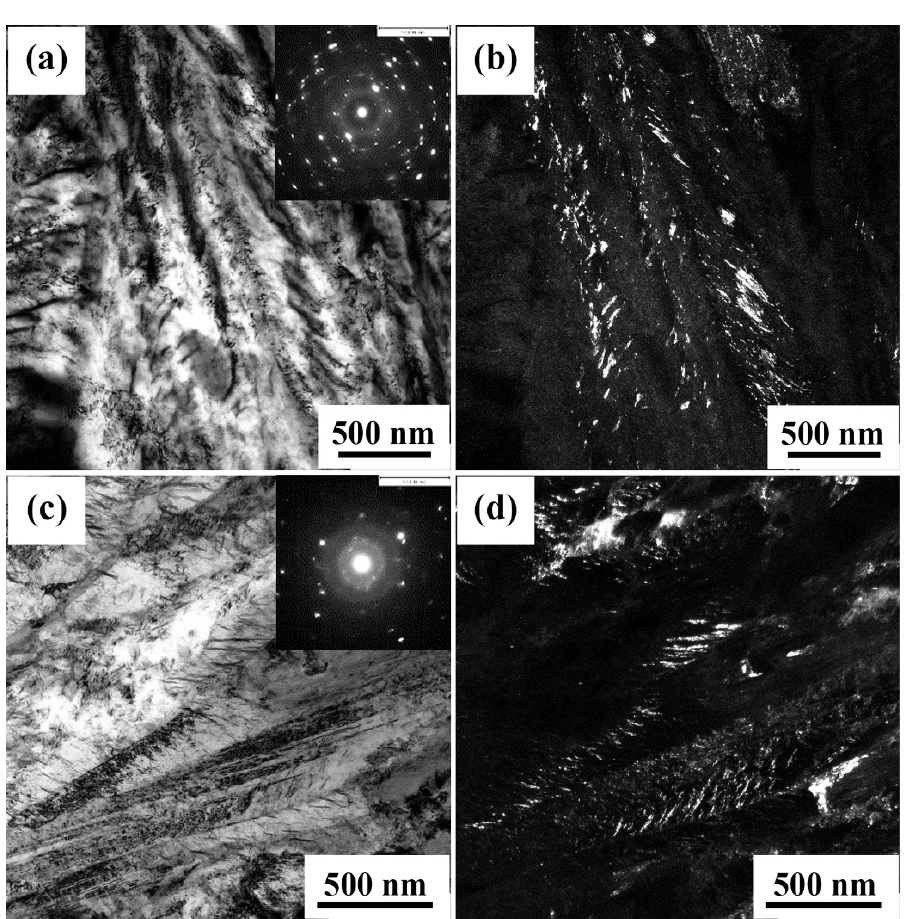
Figure 11. TEM images of specimens held at 350 °C ( a , b ) and 200 °C ( c , d ) for 1 h. The BF images with inset SAED patterns and the DF images from the diffraction spots are shown for carbide detection. Vickers hardness measurements were conducted on all the Q&B and Q&P samples and the data are presented in Table 3. As isothermal holding temperature decreased